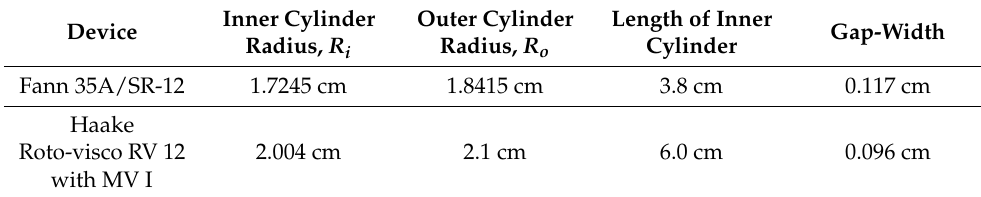
Table 3. Relevant dimensions of viscometers used in this